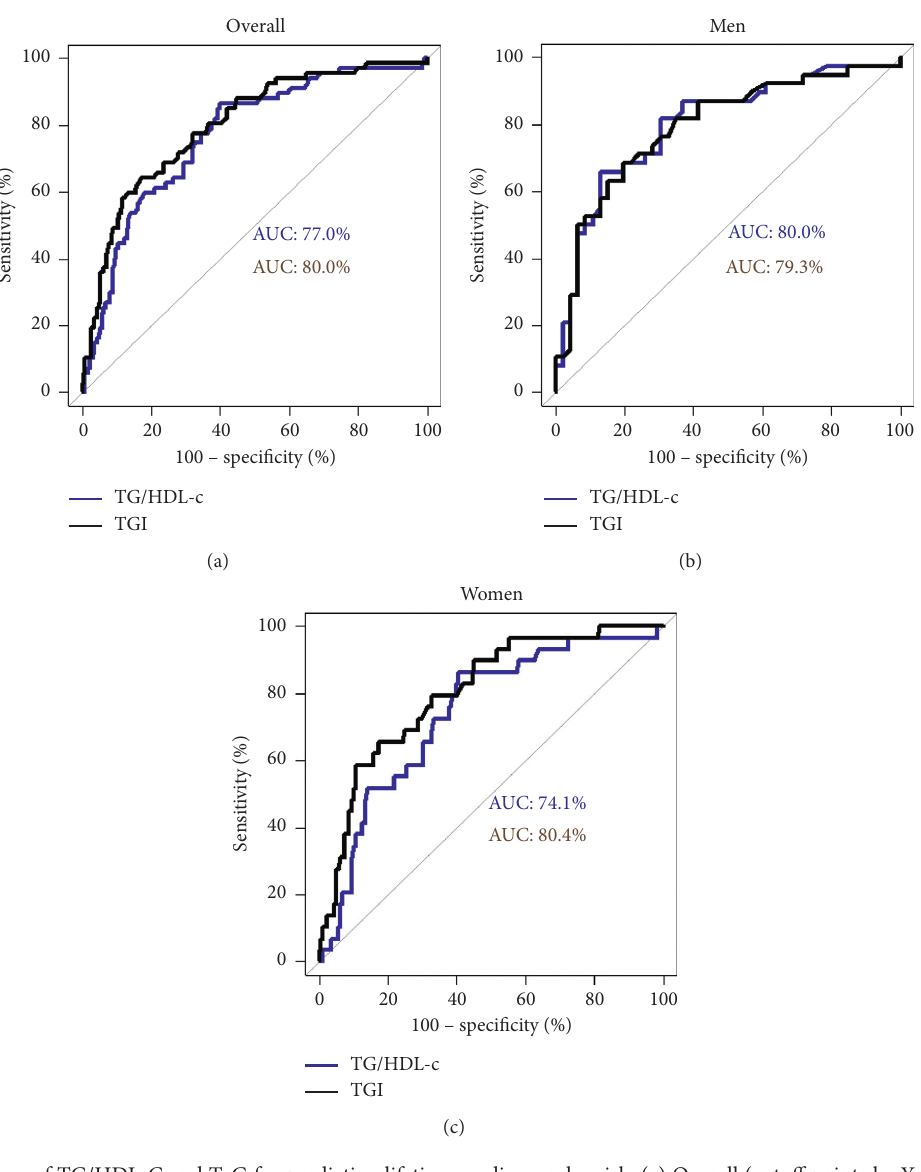
Figure 1: ROC curve of TG/HDL-C and TyG for predicting lifetime cardiovascular risk. (a) Overall (cutoff points by Youden index, TG/ HDL-C: 2.64; TyG: 9.04). (b) Men (cutoff points by Youden index, TG/HDL-C: 3.90; TyG: 8.95). (c) Women (cutoff points by Youden index, TG/HDL-C: 2.64; TyG: